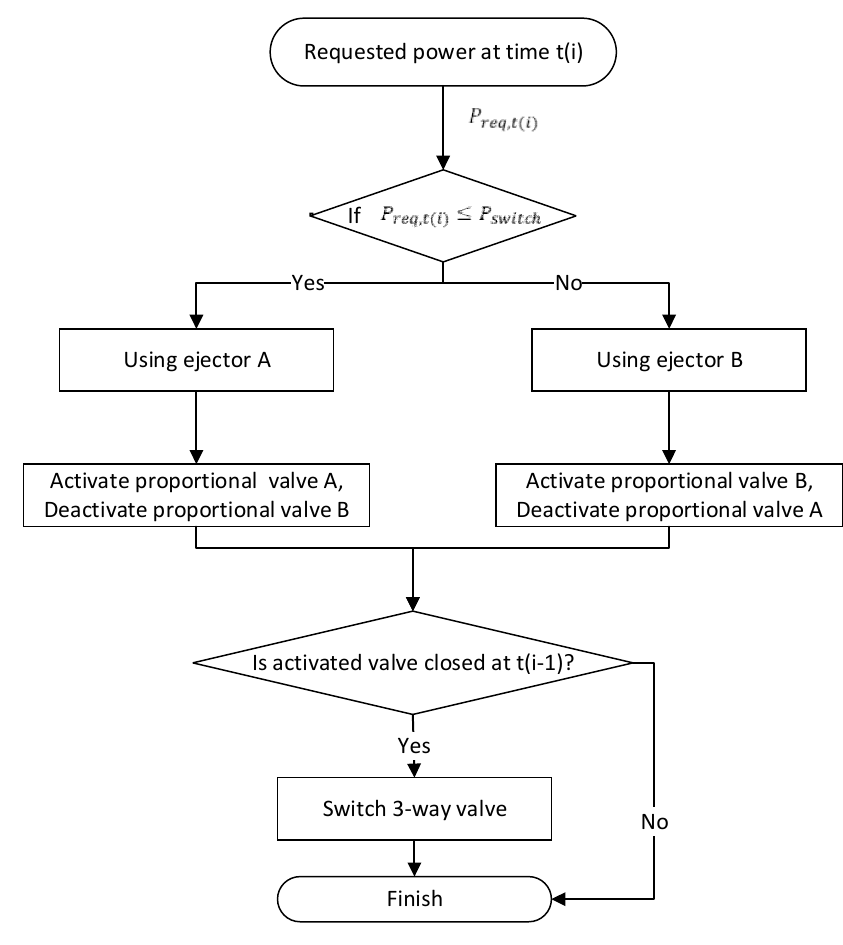
Figure 8. Control logic for the dual ‐ ejector system.